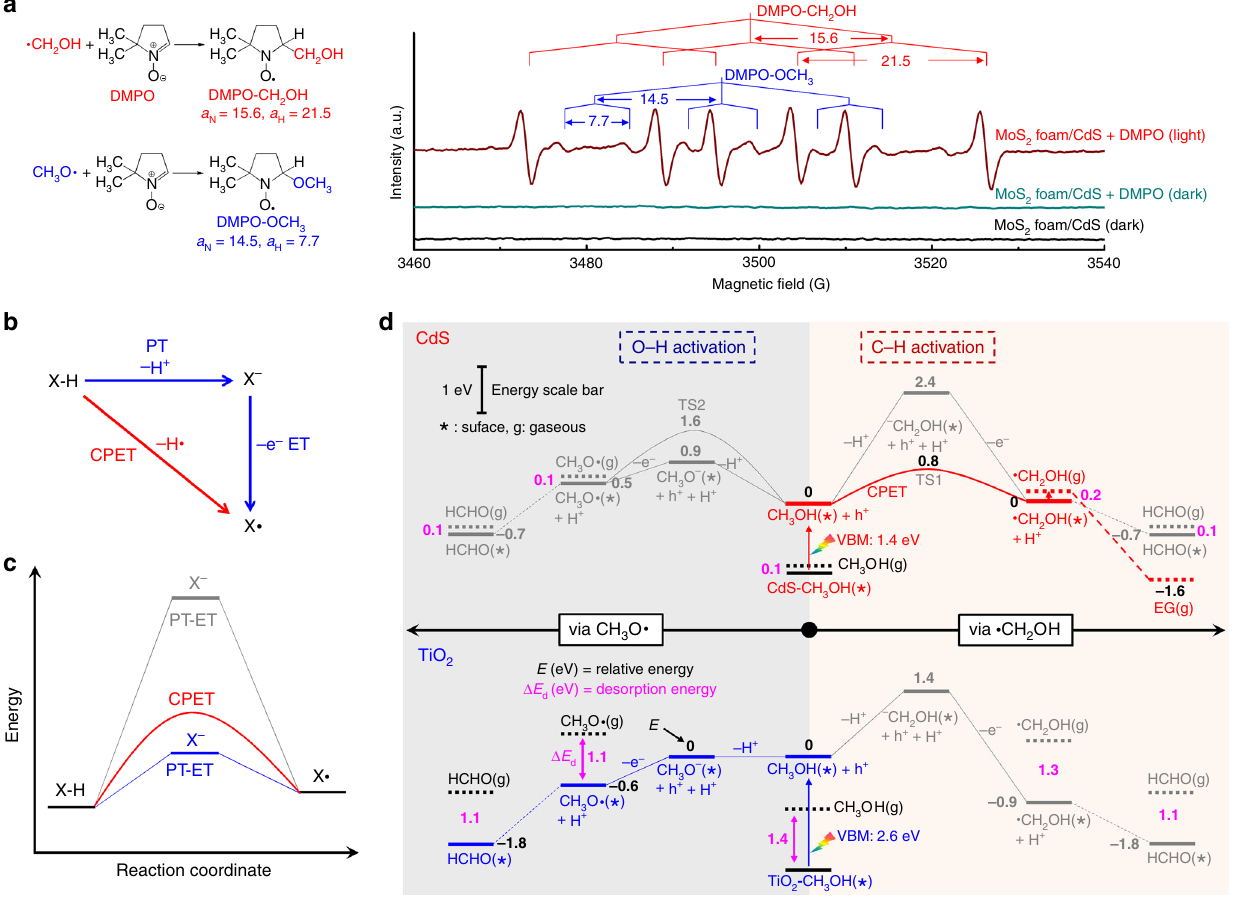
Fig. 2 Mechanistic insights. a In situ ESR spectra for systems containing MoS 2 foam/CdS catalyst in methanol aqueous solution in the presence of DMPO (a spin-trapping agent) with or without light irradiation. b Two possible reaction pathways. c Energy pro fi le. The CPET path is favored when the stepwise PT – ET path involves a high-energy intermediate. d Reaction energy pro fi les via ⋅ CH 2 OH and CH 3 O ⋅ on CdS(100) and rutile TiO 2